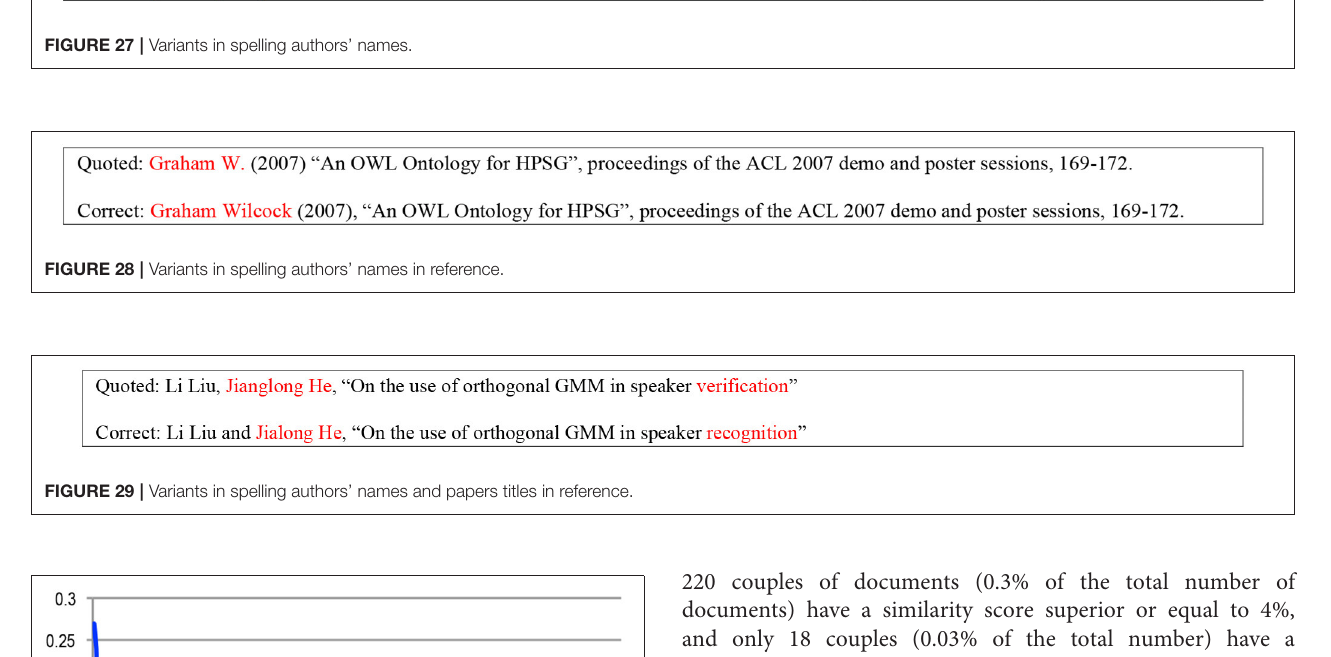
FIGURE 27 | Variants in spelling authors’ names.